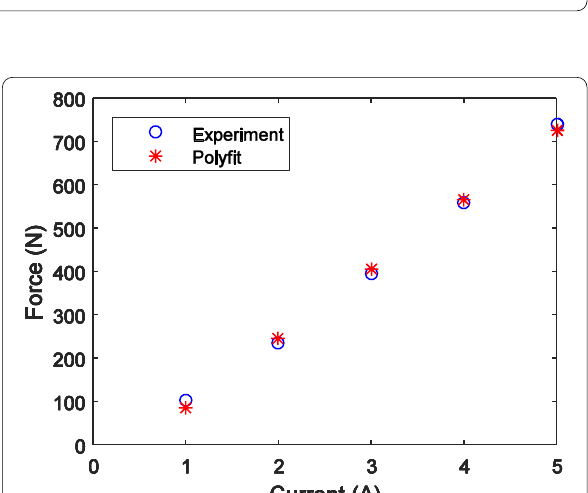
Figure 5 Dynamic force experiment platform of the MA